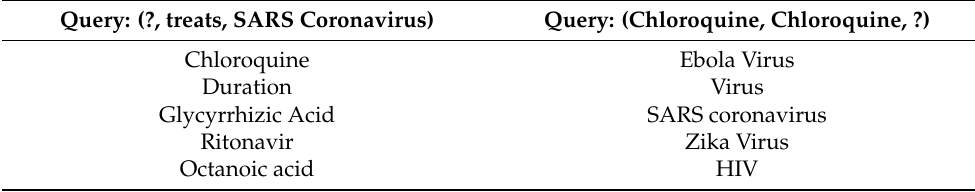
Table 4. Example results from the Entity prediction API with two different queries. In the first column, the query to the API (entity: SARS coronavirus, relation: treats, size: 5, method: Ensemble, is_head: False) and head entity predictions are displayed. In the second column, query (entity: Chloroquine, relation: Chloroquine, size: 5, method: Ensemble, is_head: True) and the predictions of tail entity are